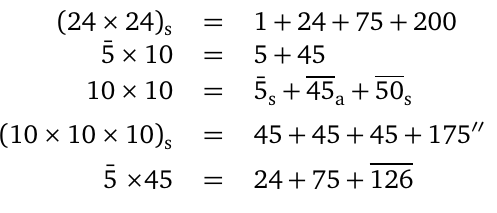
Table 6: The tensor products of representations of SU ( 5 ) .